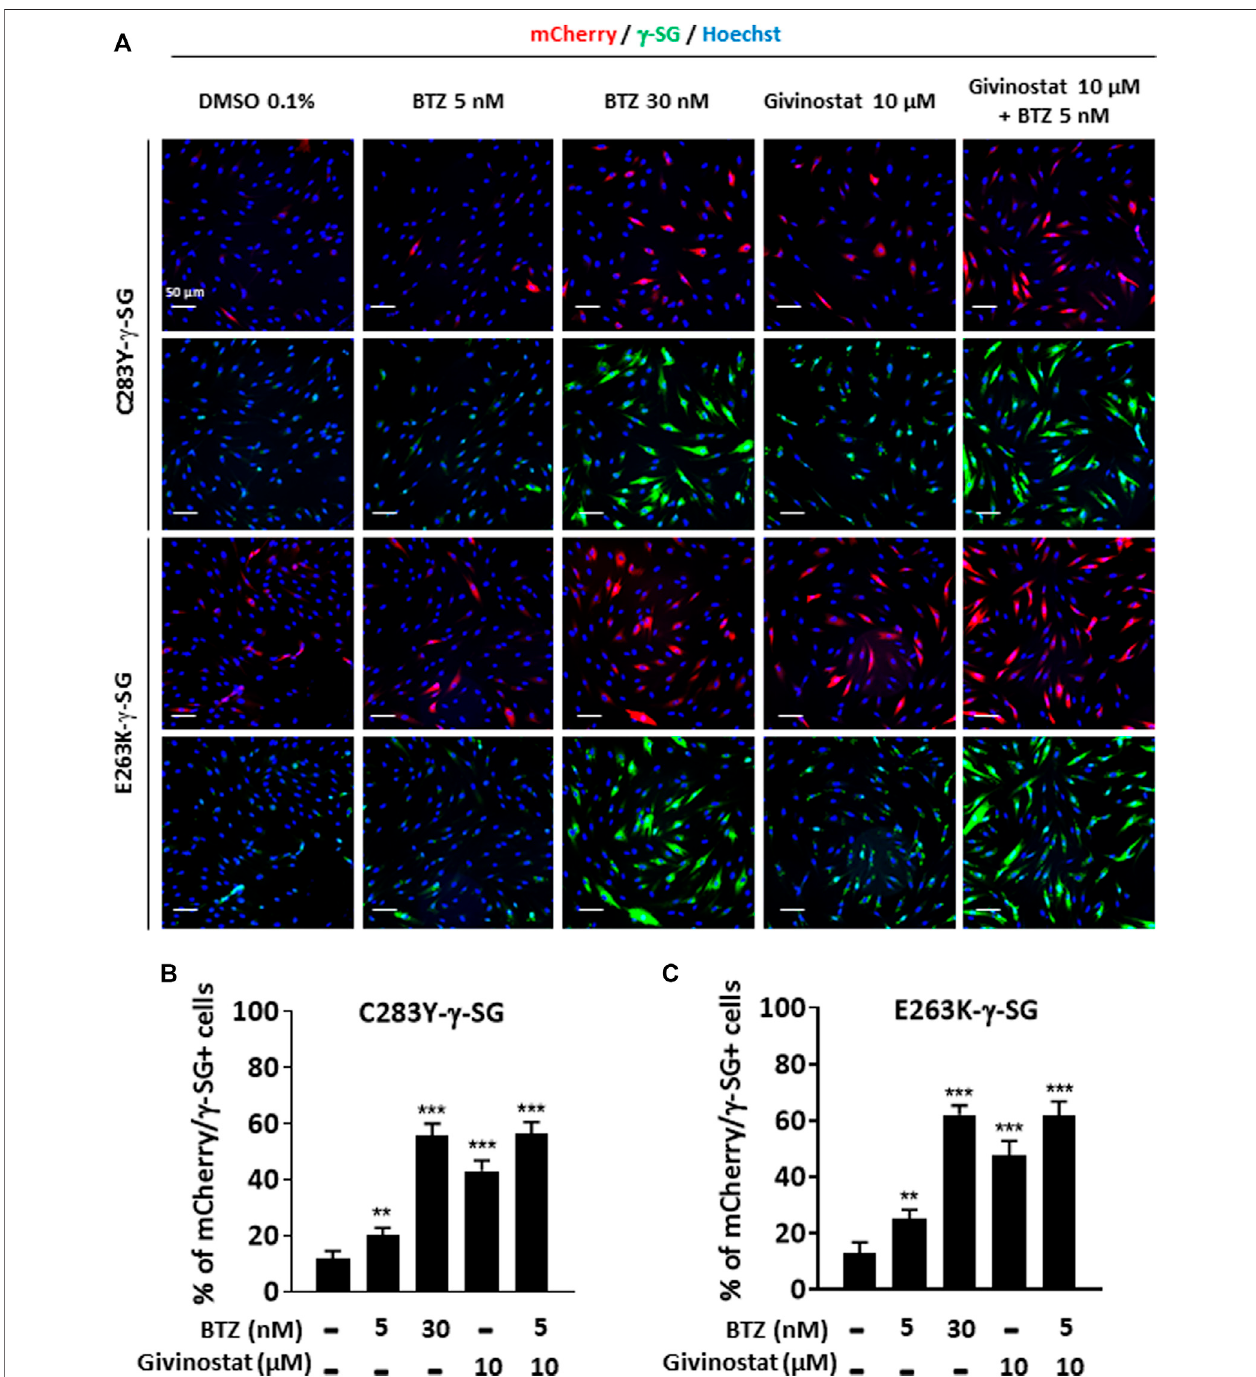
FIGURE 3 | Evaluation of givinostat and bortezomib combination on γ -SG mutated proteins. (A) Images of mCherry fl uorescent signal (red) and membrane γ -SG stainingundernon-permeabilized condition(green)ofSGCG − / − fi broblasts transducedwithlentivirusexpressingC283Y- γ -SGmChorE263K- γ -SGmChconstructsand treatedwith DMSO (0.1%), BTZ (5 and 30 nM) orgivinostat (10 μ M) in presence or inabsenceof5 nM BTZ for 24 h. Nuclei are labelled byHoechststaining(blue).Scale bar=50 μ m. (B,C) Quanti fi cationofmCherryandmembraneC283Y- γ -SG (B) andE263K- γ -SG (C) positive fi broblasts.Eachchartrepresentsthemean±SD( n = 4) of a representative experiment over three independent experiments; * p ≤ 0.05, *** p ≤ 0.001 (Student ’ s t-test). BTZ, bortezomib.